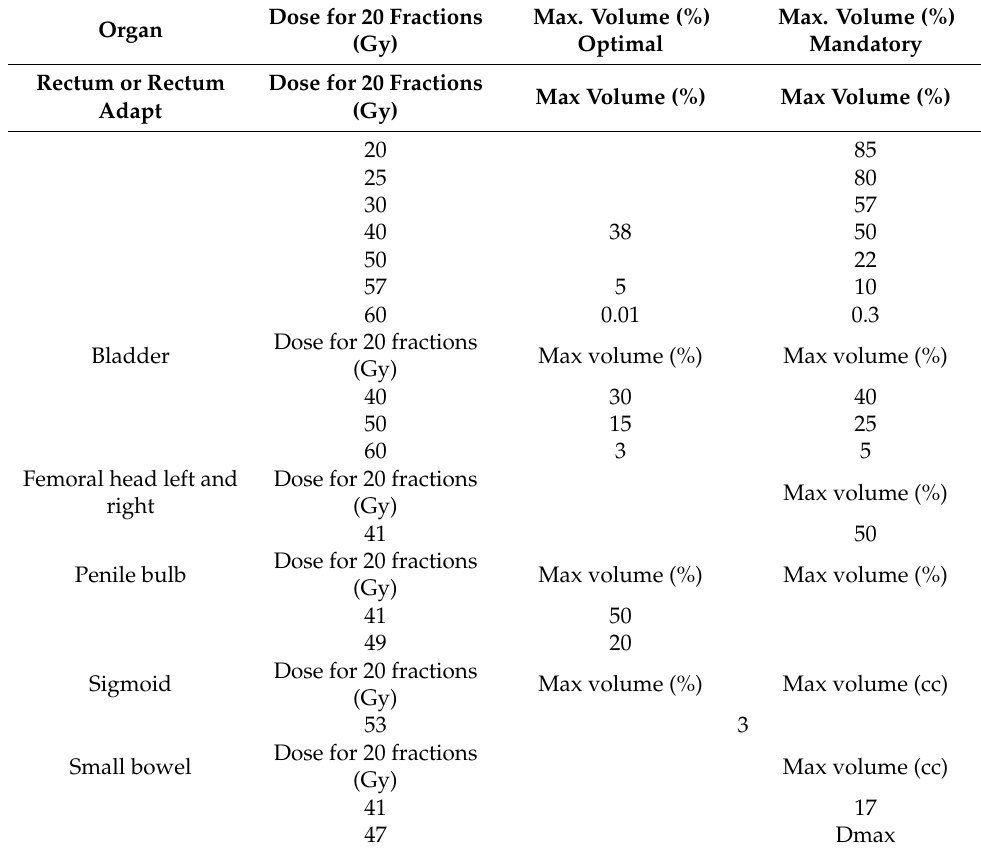
Table 5. Dose constraints for organs at risk for moderate hypofractionation in 20 fractions (control arm). Rectum_adapt will be generated by delineation of the rectum in the co-registered CB-CTs, MV-CTs or MRI images of the first three fractions. Manual delineation of the Rectum_adapt should consider the mean rectal